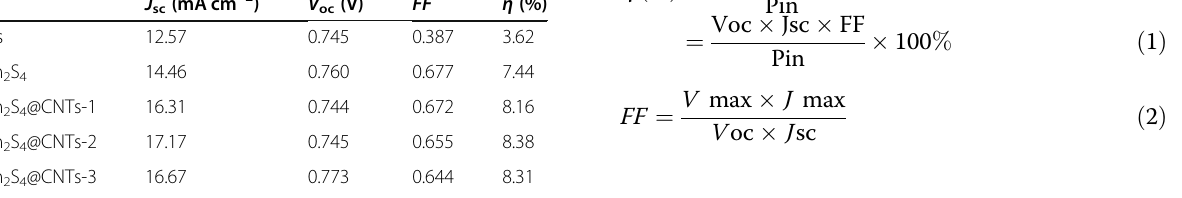
Table 3 Photovoltaic parameters of DSSCs CEs